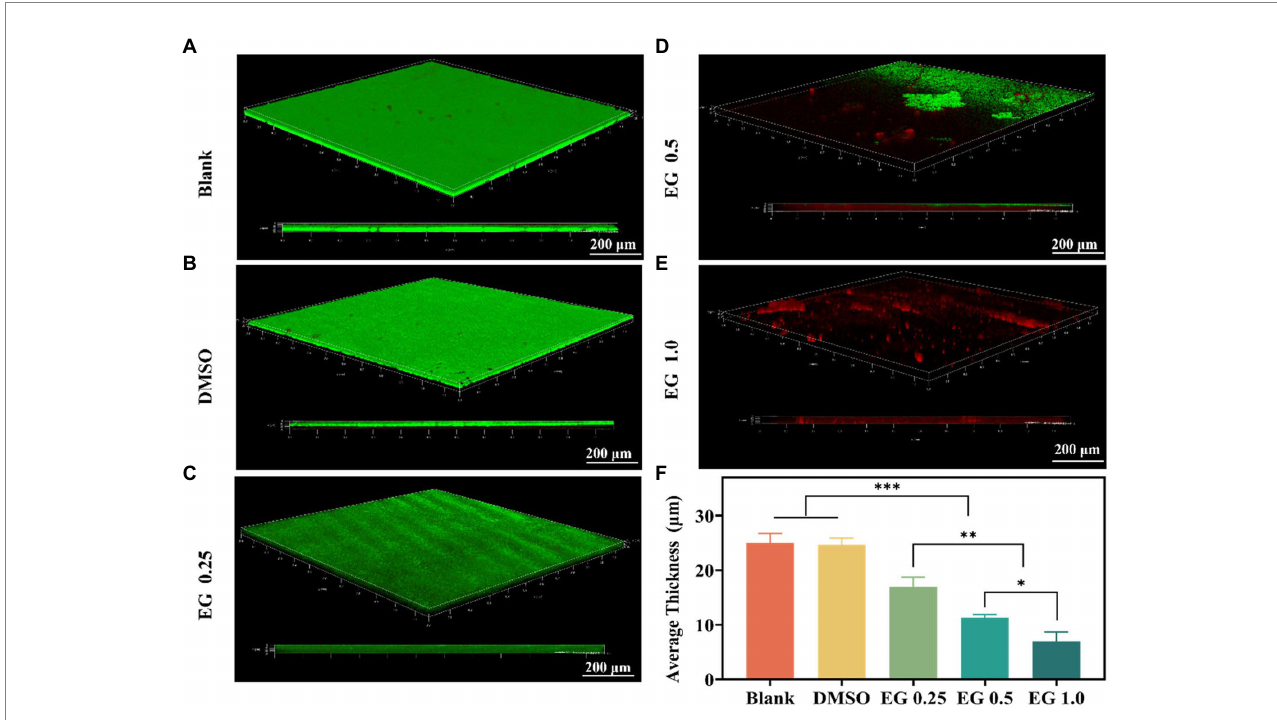
FIGURE 2 confocal laser scanning microscope (CLSM) images of CRKP biofilms were grown for 12 h and treated with EG for 36 h. Biofilms grown in (A) Blank, (B) DMSO (1%), (C) EG 0.25, (D) EG 0.5, (E) EG 1.0. Green is live bacteria. Red is dead bacteria. Scale bars = 200 μ m. (F) The average thickness of CRKP biofilms.